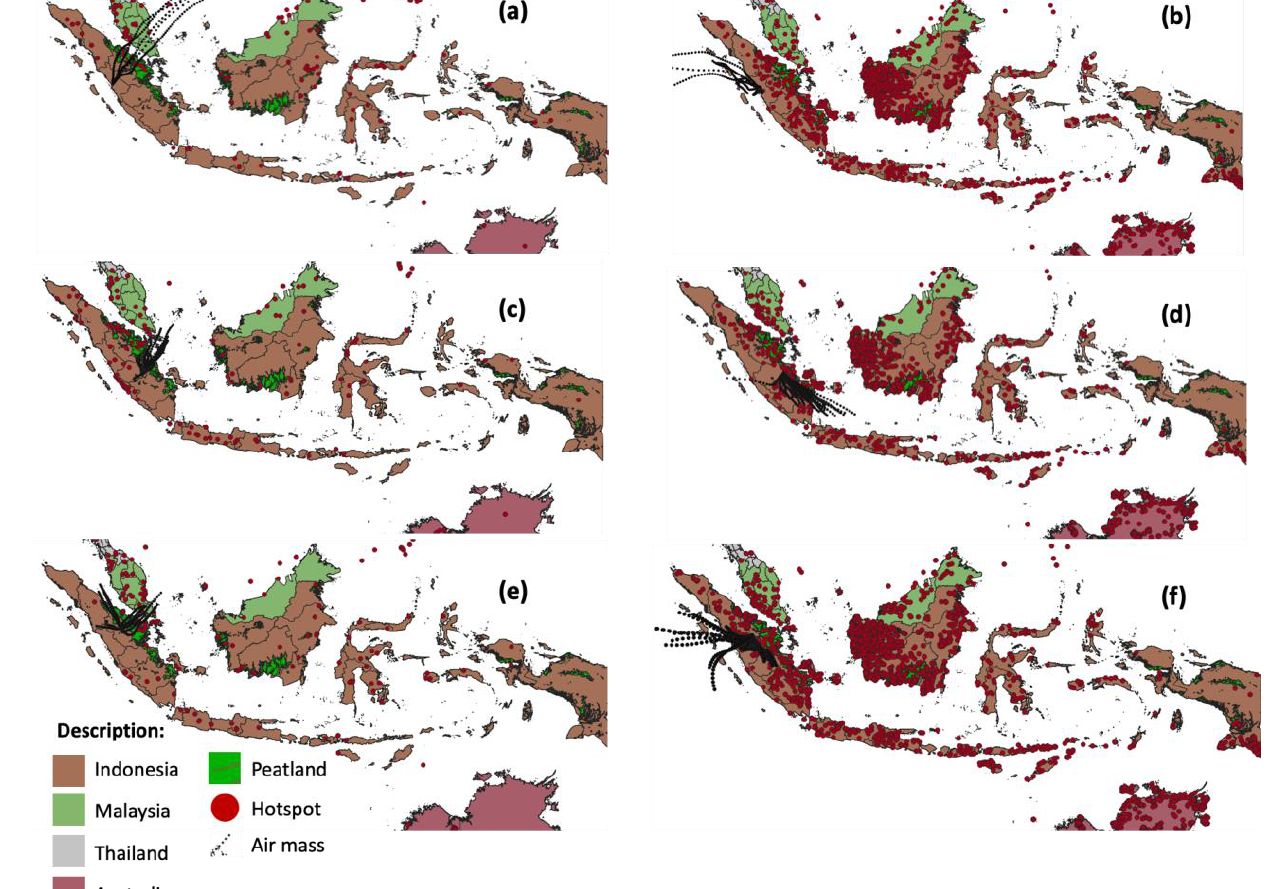
Figure 5. Seasonal air mass backward trajectory in Sumatra island: ( a ) Padang (rainy), ( b ) Padang (dry), ( c ) Jambi (rainy), ( d ) Jambi (dry), ( e ) Pekanbaru (rainy), and ( f ) Pekanbaru (dry).